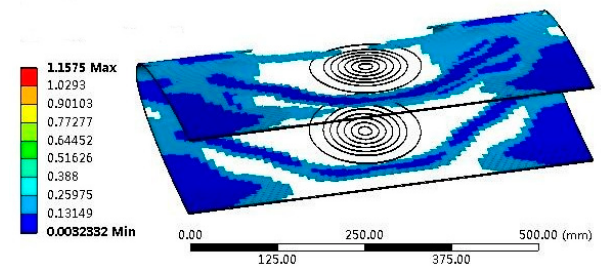
Figure 18. Electro-impulse de-icing (EIDI) system of two coils (Mode 4).